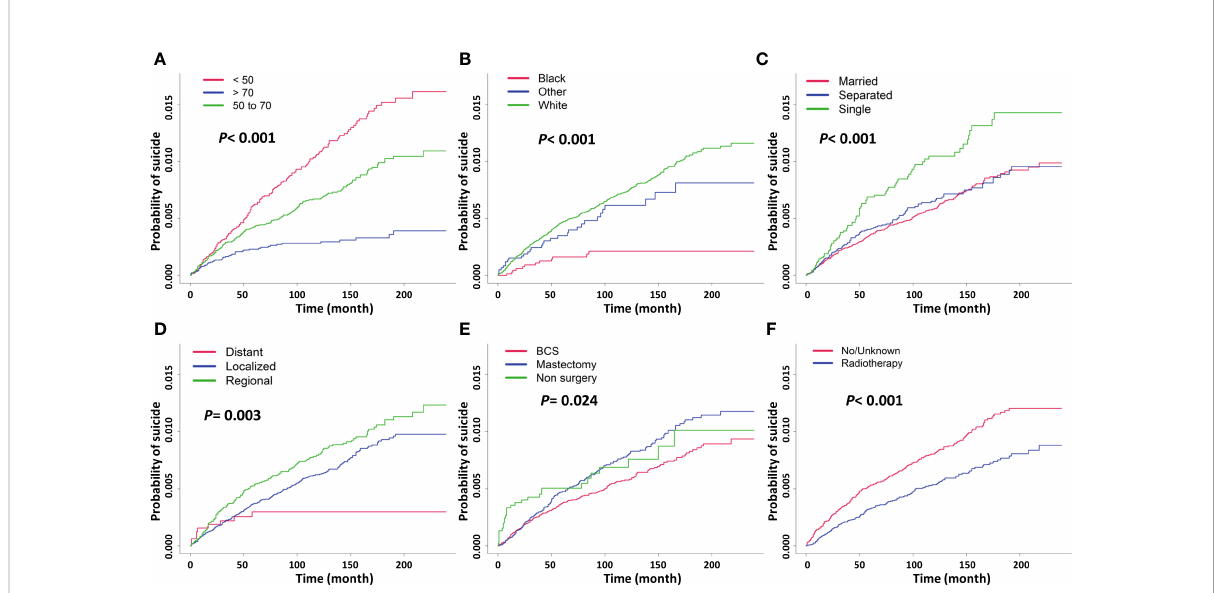
FIGURE 2 Cumulative incidence estimates of suicide among female breast cancer survivors by different risk factors, (A) age group, (B) race/ethnicity, (C) marital status, (D) stage, (E) surgery type, (F)